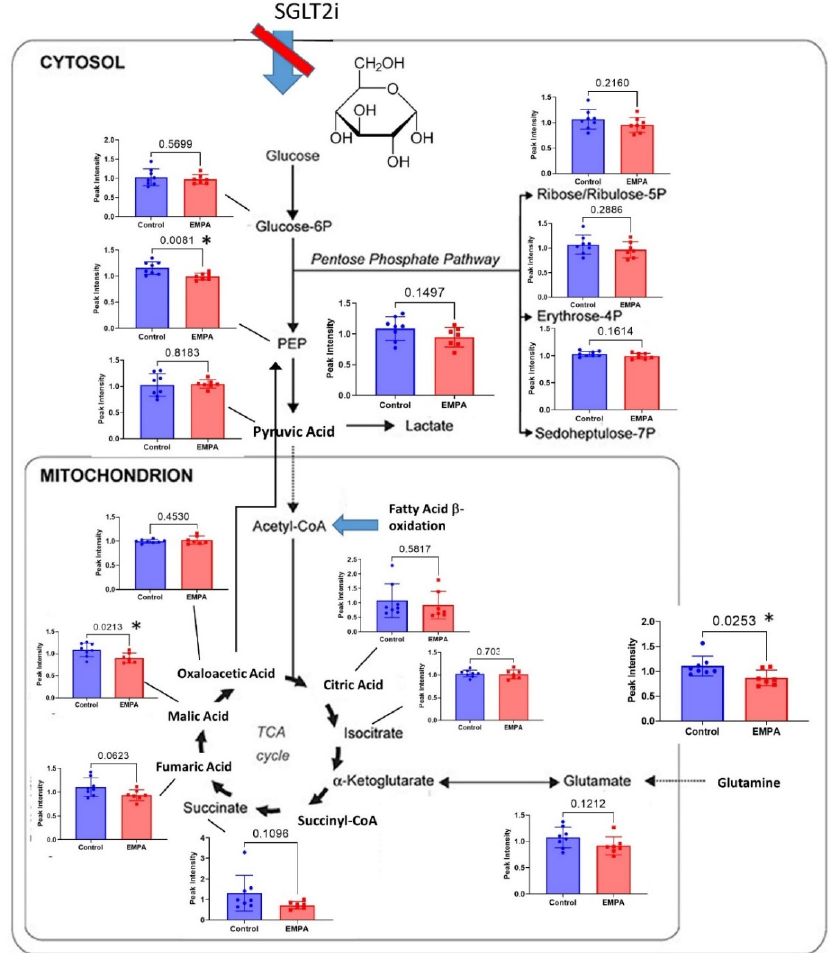
Figure 5. Metabolites involved in glycolysis and oxidative phosphorylation in general, were reduced with EMPA-Control (blue) and EMPA-treated (red) bars showing individual mouse values and mean (SEM) for metabolites evaluated in these pathways ( n = 8 control, n = 7 EMPA); * indicates a significant difference by unpaired t -test ( p < 0.05). Phosphoenolpyruvate (PEP), malic acid, and glutamine were down-regulated with p < 0.05. Succinate was reduced, on average, 45%. Table 4. Metabolite Theoretical Annotation in Untargeted Species ‡